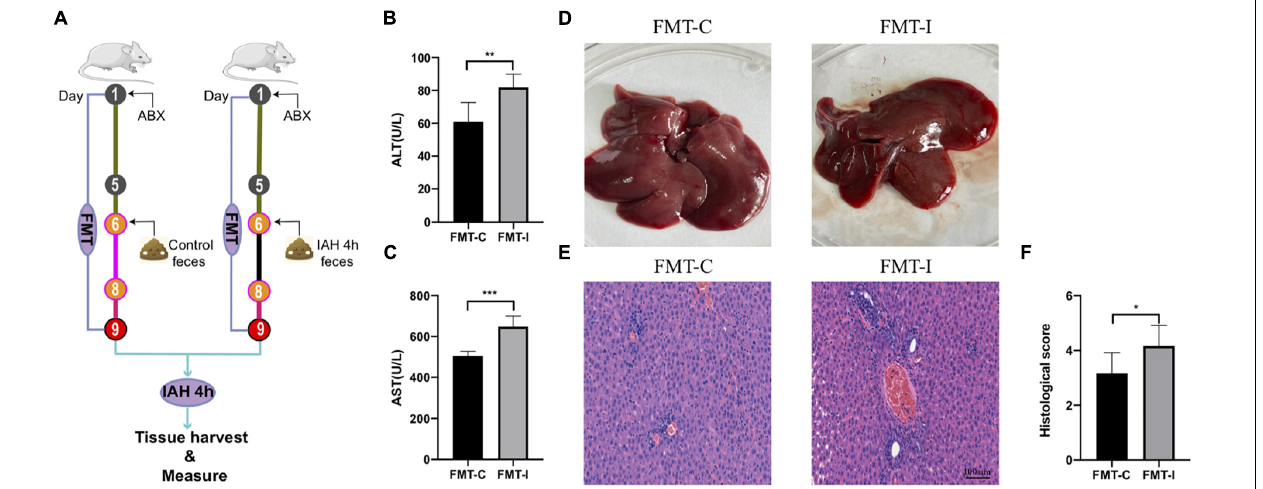
FIGURE 5 | IAH-associated liver injury was aggravated by FMT of donor feces from IAH-intervened rats. (A) FMT operation diagram. (B,C) The levels of plasma ALT and AST. (D) Representative liver morphology. (E,F) HE staining and histological score of liver injury (mean ± SD. * p < 0.05; ** p < 0.01; *** p < 0.001; FMT-C group vs. FMT-I group; n = 6 per